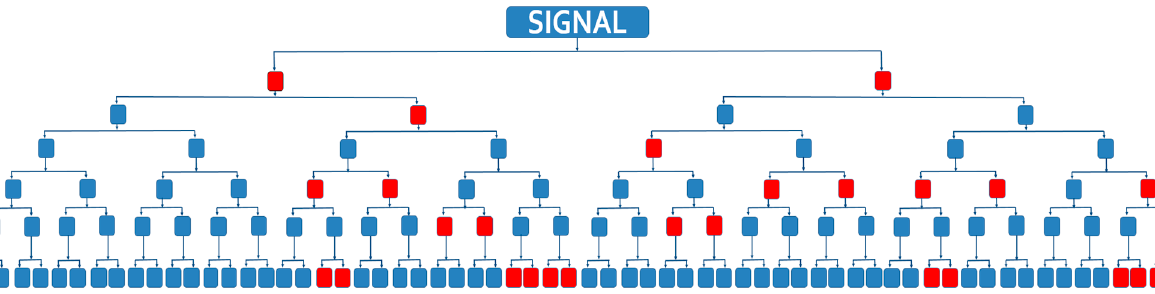
Figure 2. Constructed tree.